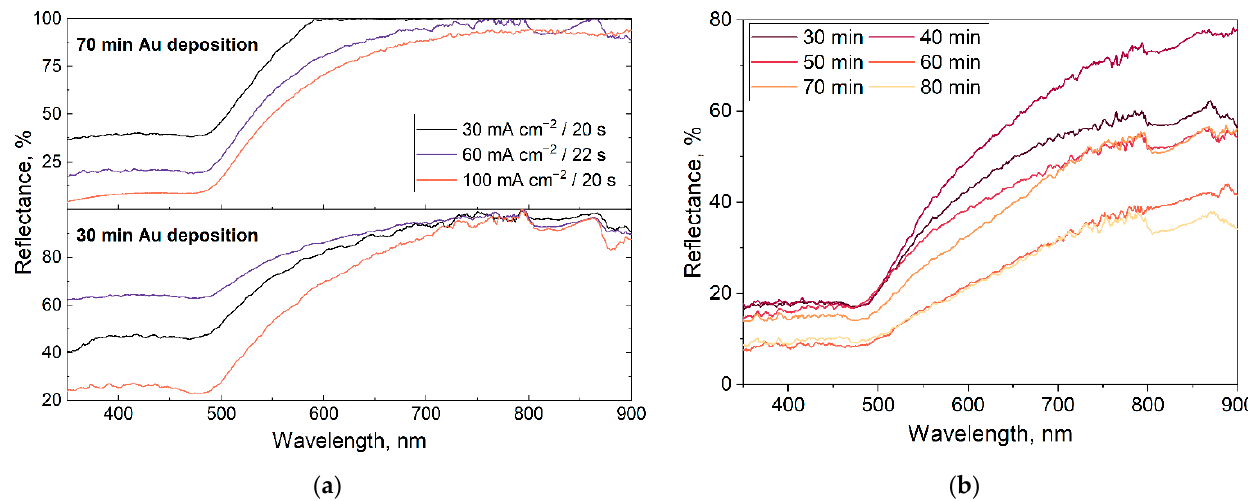
Figure 9. Reflectance spectra for the meso-PS ( a ) and macro-PS ( b ) samples after Au deposition for different time periods. Table 1. Fabrication regimes for the Au-coated meso- and